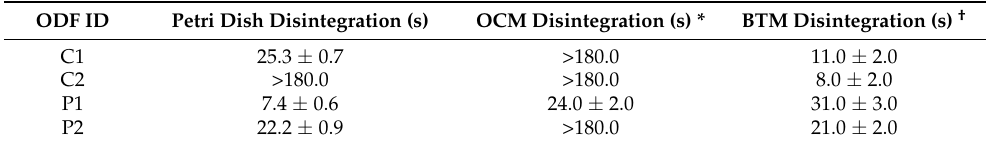
Table 4. ODF mean disintegration times using the modified Petri dish, OCM and BTM methodologies, with standard deviations ( n = 3).